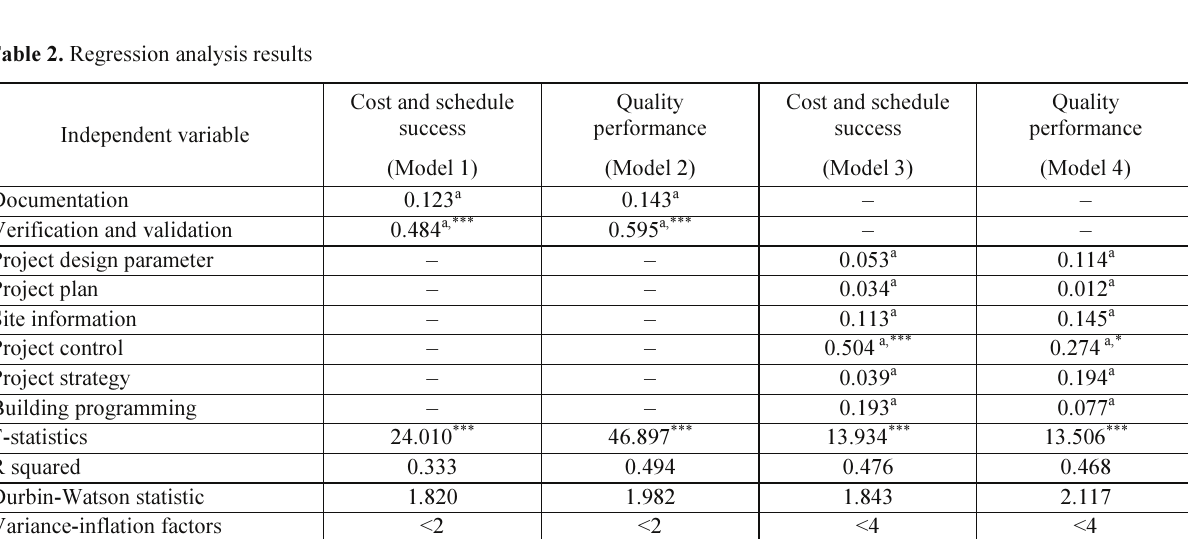
Table 2. Regression analysis